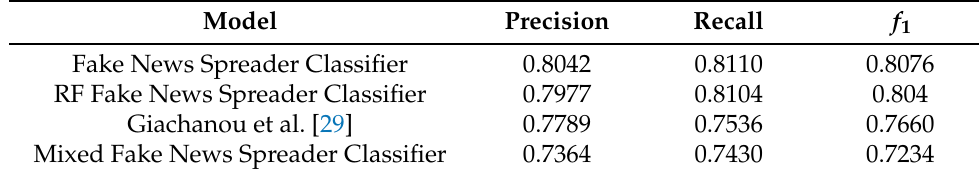
Table 6. Precision, recall and f 1 scores computed as a comparison between our proposed Fake News Spreader Classifier model; our RF Fake News Spreader Classifier, that is a Random Forest model exploiting Twitter user’s information; the baseline by the work of Giachanou et al.; and a mixed model receiving Twitter user account information and tweet embeddings as input in a stacked neural network. As suggested by the results, we consider the Fake News Spreader Classifier as the most effective in user classification thanks to the overall higher